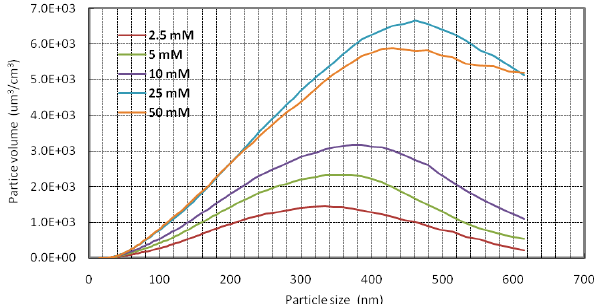
Fig. 5. Particle volume size distributions for different (NH 4 ) 2 SO 4 Fig.5. Particle volume size distributions for different (NH 4 ) 2 SO 4 concentration used concentration used for particles generation. for particles generation